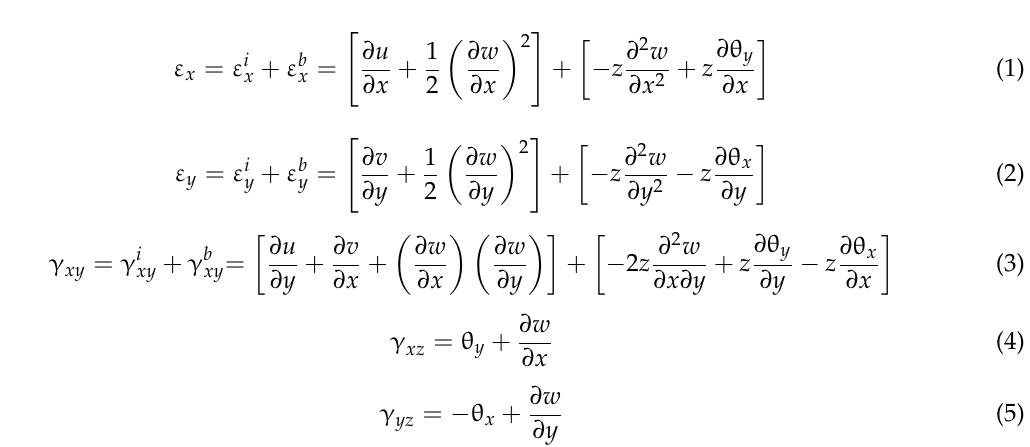
two layers of welding were applied to each butt and fillet